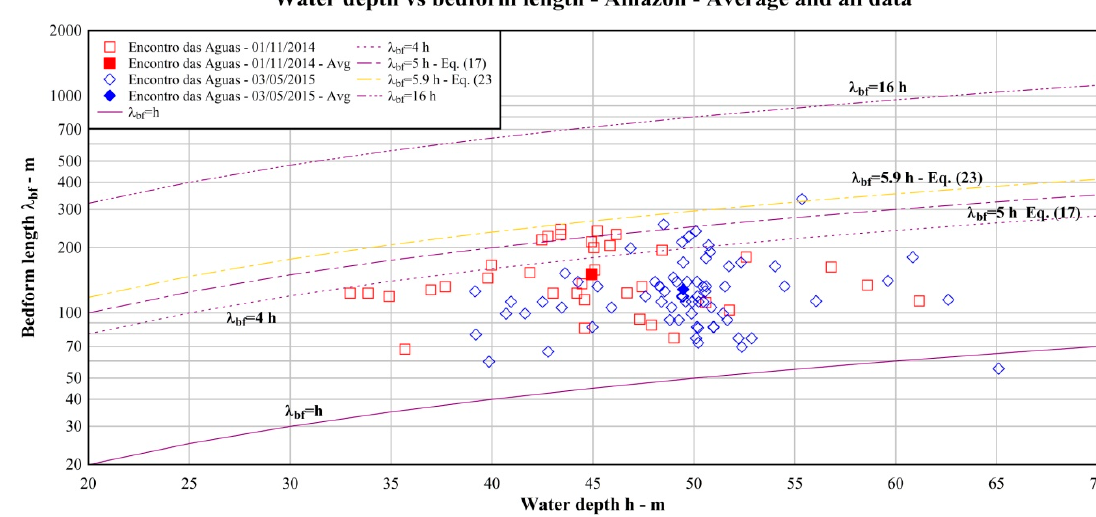
Figure 14. Bedform wavelength vs. water depth.